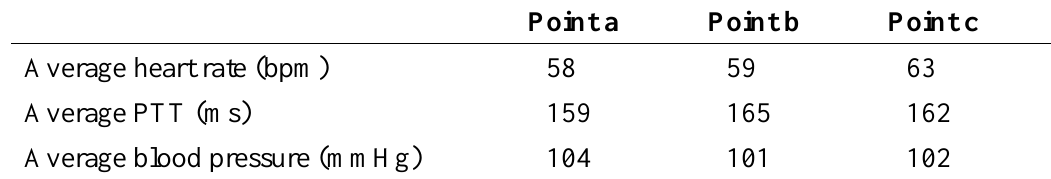
Table 1. Heart rate, PTT and blood pressure estimated from ECG and